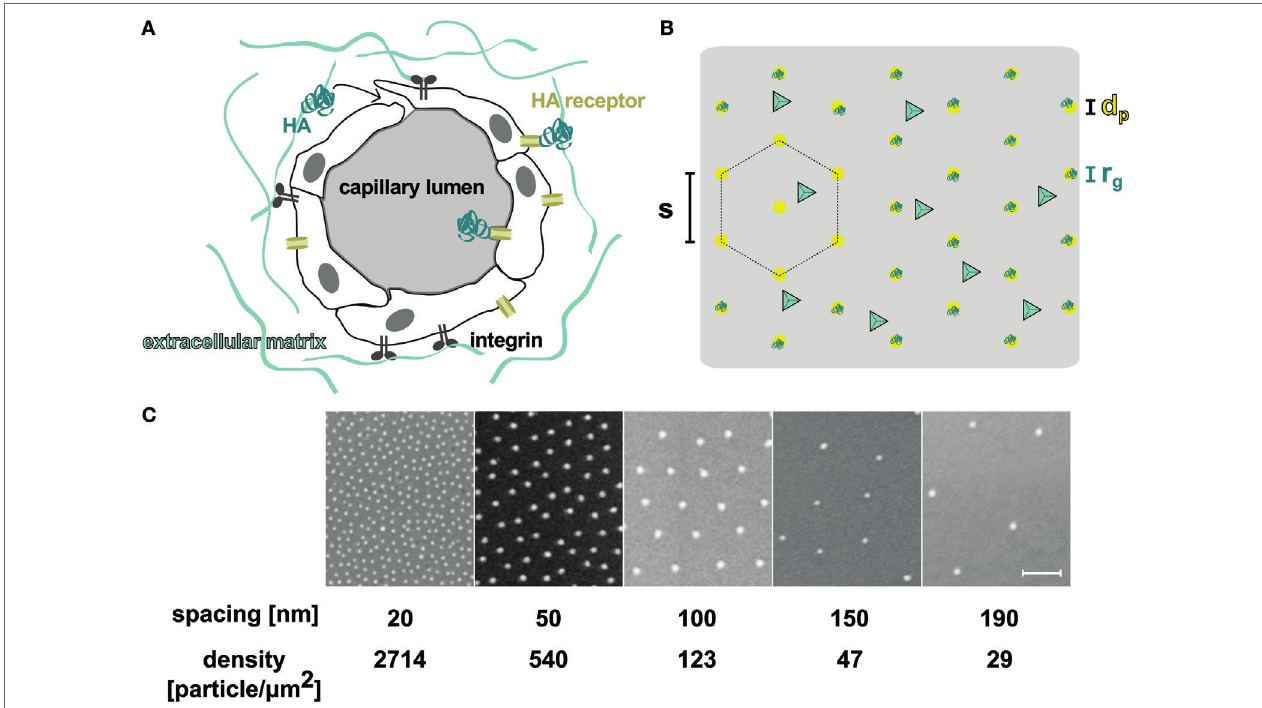
FigUre 1 | (a) Scheme of the possible sites where interactions between hyaluronan (HA) and lymphatic capillaries take place. The HA receptor such as LYVE-1, CD44, or RHAMM is located on both the luminal and basal surfaces of the cells. (B) The orthogonal functionalized surface used in these experiments was passivated with polyethylene glycol, which was further modified with cyclic RGD ligand (light blue tetrahedron). The nanostructures had a particle diameter of d p = 10 nm, and were functionalized with HA oligosaccharides [turquoise, radius of gyration r g = 7.1 nm (Kuehl et al., 2016)]. The hexagonal packed particles had variable interparticle spacings (s). (c) SEM pictures of the nanostructured surfaces with different interparticle distances. Scale bar corresponds to 100 nm.